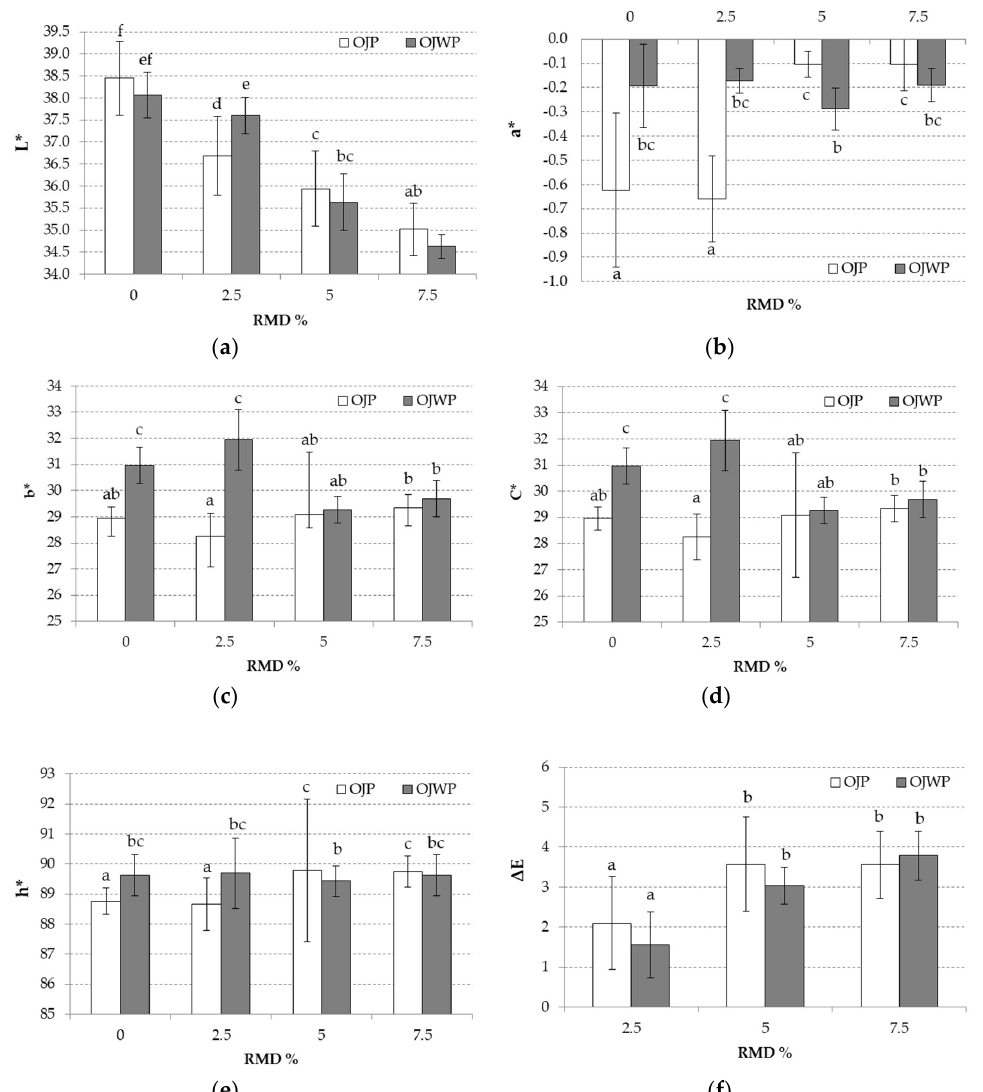
Figure 5. Mean values (and standard deviations) of colour coordinates L* ( a ), a* ( b ), b* ( c ), C* ( d ), and h* ( e ) and total colour differences (ΔE, ( f )) of pasteurised orange juice. Letters indicate homogeneous groups established by the ANOVA ( p < 0.05) for each parameter analysed. OJP, orange juice with pulp; OJWP, orange juice without pulp.